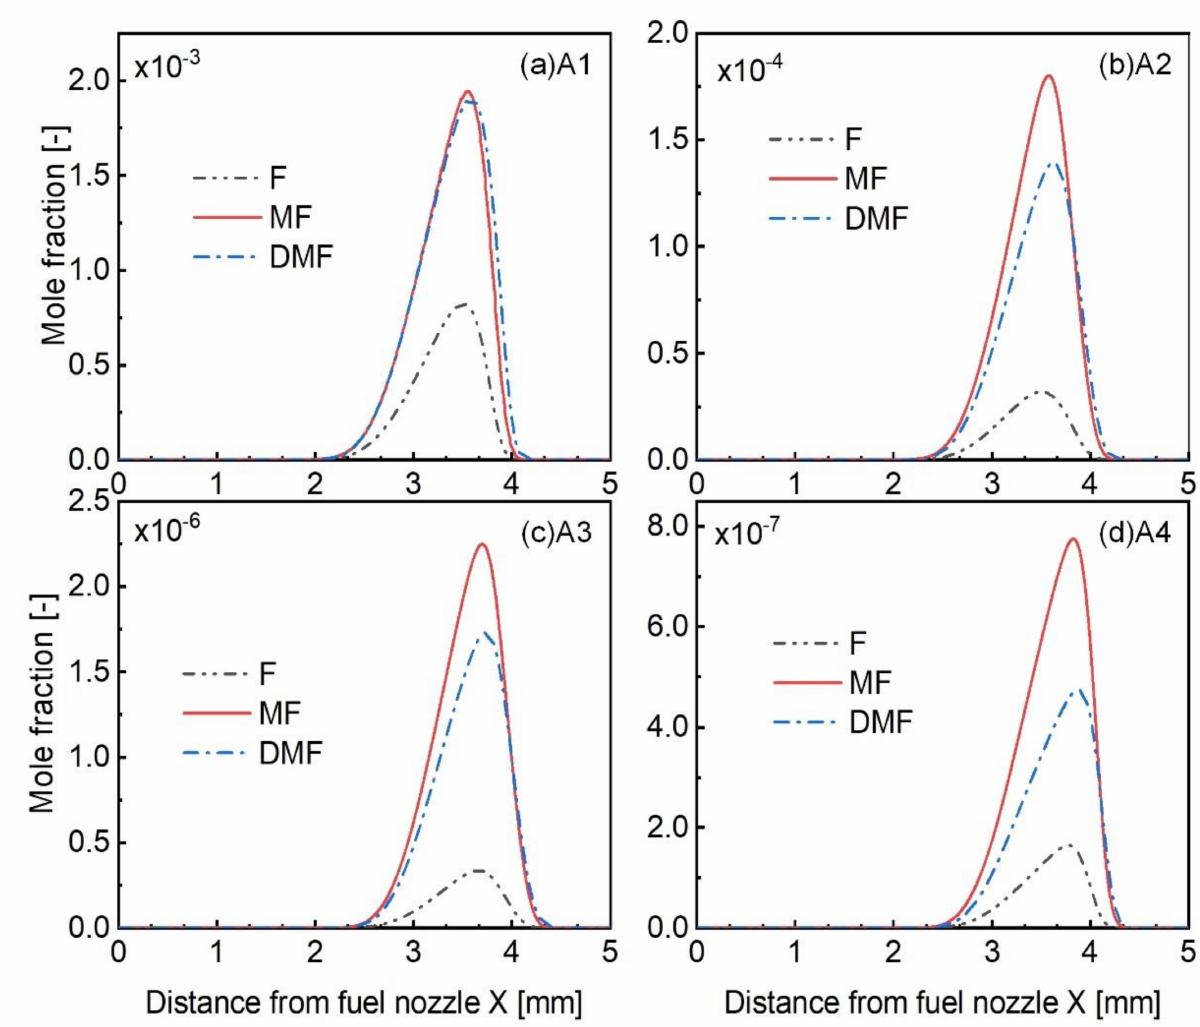
Figure 6. Computed mole fractions of A1-A4 for furan, MF, and DMF